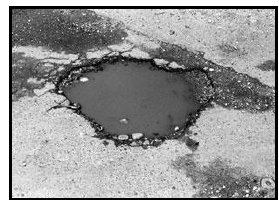
Figure 1. Hole Creation on the Road (Movea, 2013)